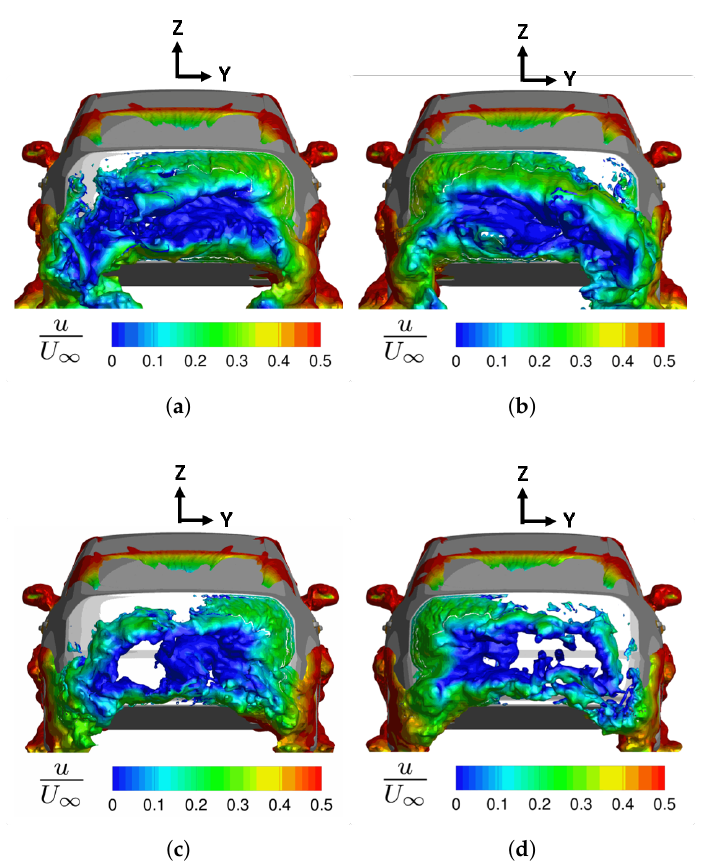
Figure 8. Iso-surface of the instantaneous total pressure coefficient C p 0 = − 0.025 for the ( a ) Maximum C S (stationary wheels), ( b ) Minimum C S (stationary wheels), ( c ) Maximum C S (rotating wheels), ( d ) Minimum C S (rotating wheels). The iso-surfaces are colored by the streamwise velocity u / U ∞ to highlight the wake